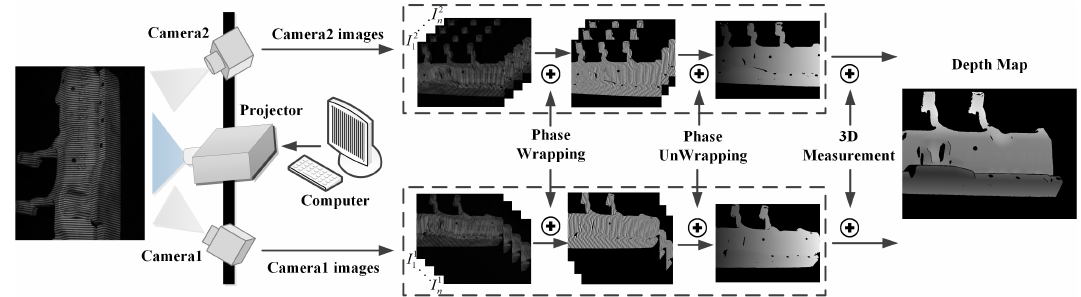
Figure 1. The 3D measurement principle of fringe projection profilometry (FPP